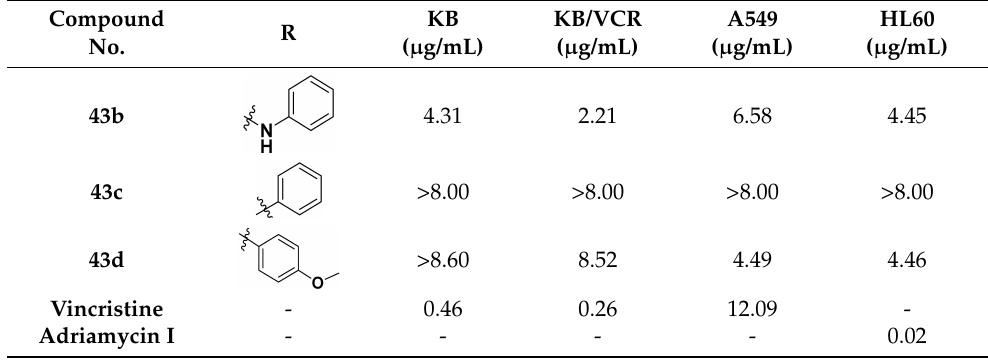
Figure 48. Structure of quinone based pyran hybrids and the most promising compound 43a . Table 36. In vitro cytotoxic activities of quinone based pyran hybrid compounds 43 ( b – e ). Compound